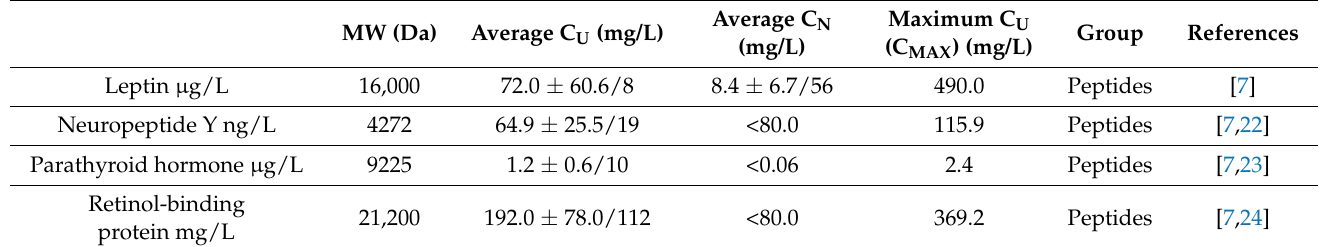
Table 3. Retention solutes third group: middle molecular